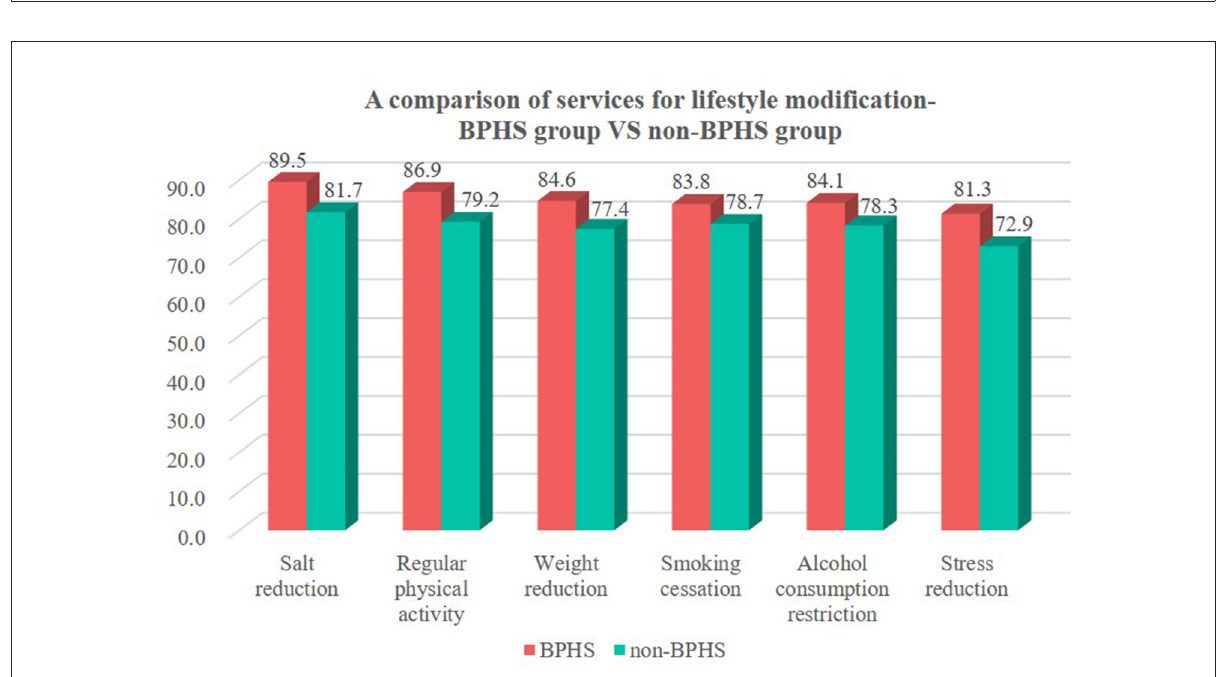
FIGURE5 Hypertension patients received lifestyle modification services among BPHS and non-BPHS groups in Yunnan